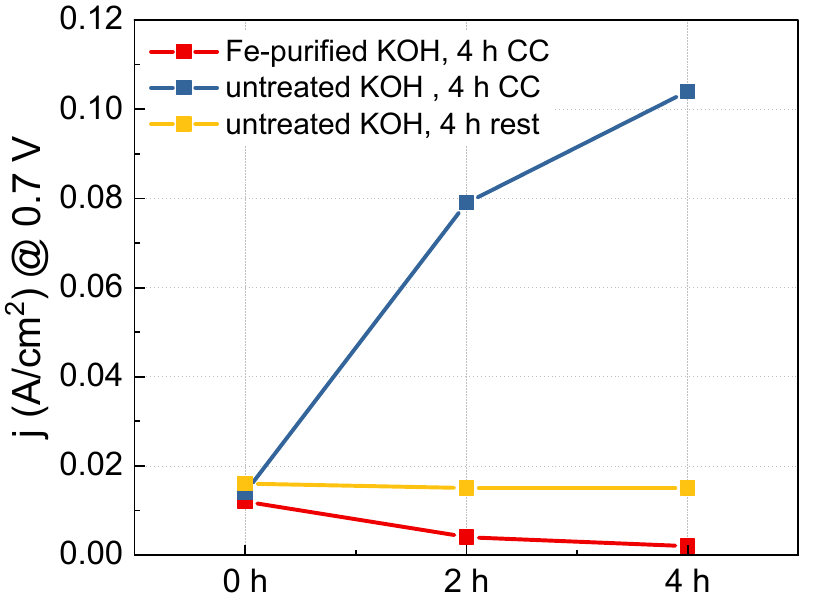
Figure 6. Current density measurements at 0.7 V of the Ni(5)-400 ◦ C electrodes performed using high purity Ni precursor with different operation conditions: 4 h CC (1.5 A/cm2) operation in purified KOH (red), 4 h CC operation in untreated KOH (blue), 4 h rest in untreated KOH (yellow).